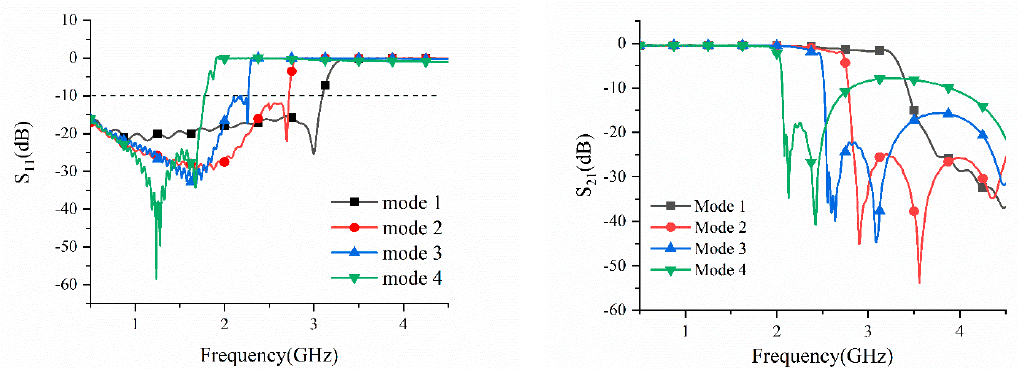
Figure 5. The simulated frequency response of the low pass filter for each